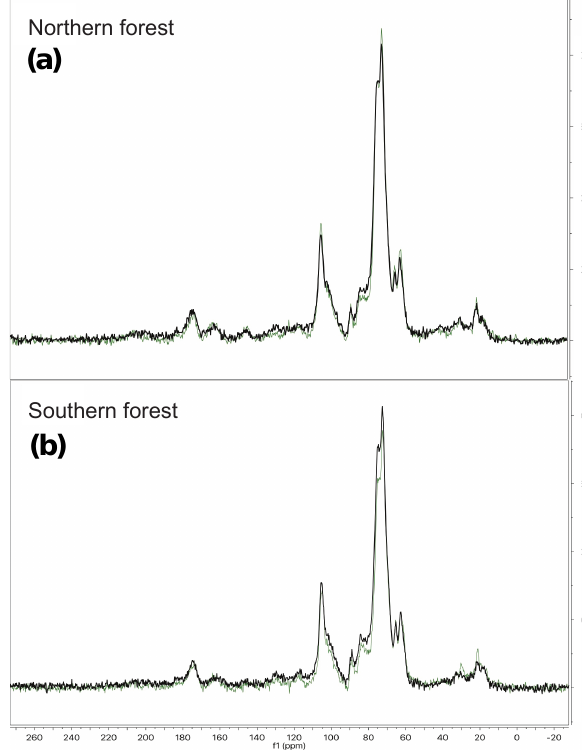
Figure 6. Examples of the CPMAS 13 C-NMR results for 4 out of 12 samples analyzed. The four chosen here are from each of the two forest sites, with one undecomposed initial moss tissue replicate and the corresponding most decomposed replicate from the final time point of the 18 ◦ C incubation. Panel (a) provides examples from the northern forest site, and panel (b) provides examples from the southern forest site. The initial samples are in green, and a final sample from the 18 ◦ C incubation is in black. The C types and their ppm range are as follows: alkyl (50–0), O-alkyl (90–65), Di-O-alkyl (110–90), aromatic (165–110), and carbonyl and amide (190–165).